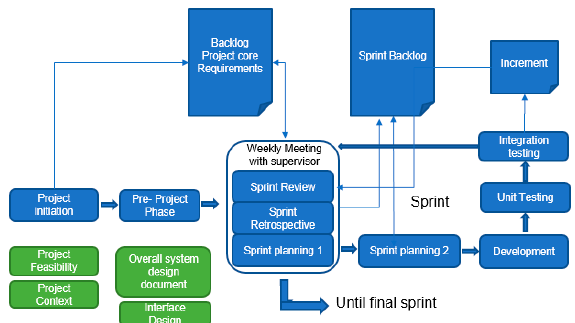
Figure 1 . Scrum agile software development process (Saeedi et al., 2021).